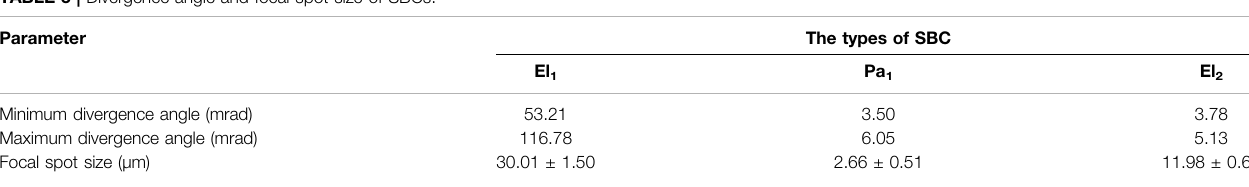
TABLE 3 | Divergence angle and focal spot size of SBCs.